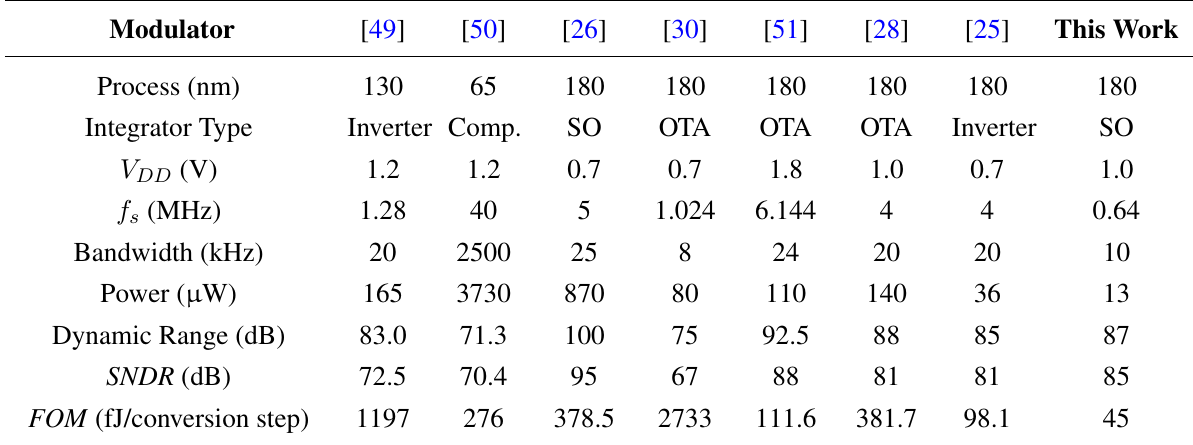
Table 3. Performance summary and